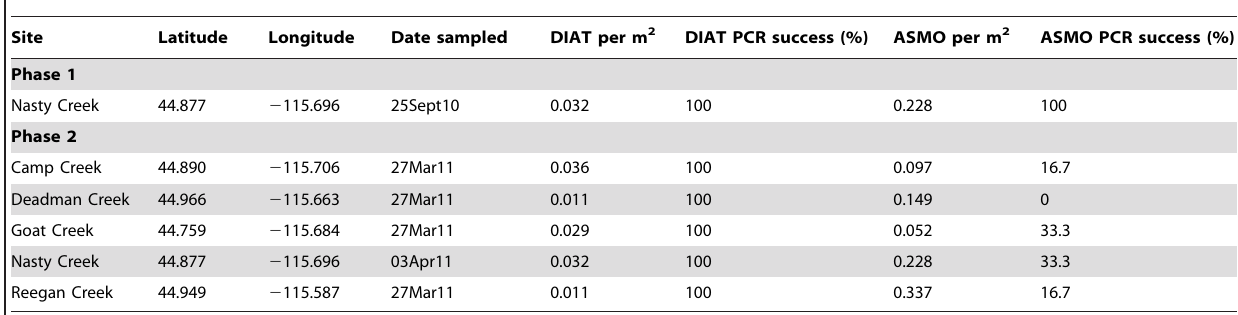
Table 1. Sampling sites, dates of sampling, PCR success for each species, and densities of Idaho giant salamanders ( Dicamptodon aterrimus; DIAT) and Rocky Mountain tailed frogs ( Ascaphus montanus ; ASMO) where stream filter samples were taken, estimated using field methods in summer